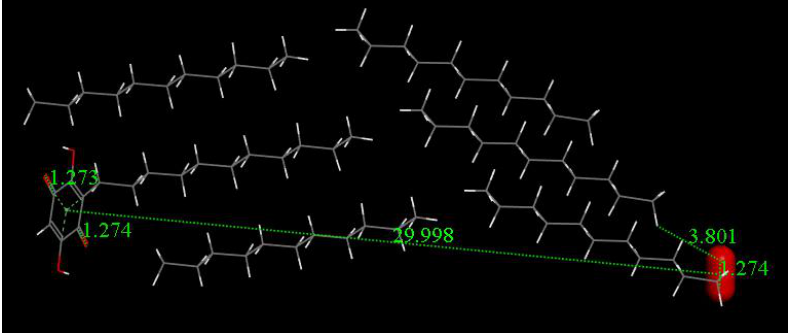
Figure 15. Distances on embelin ring moiety are the carbonyl C-O bonds, 1.274 Å and 1.273 Å . These